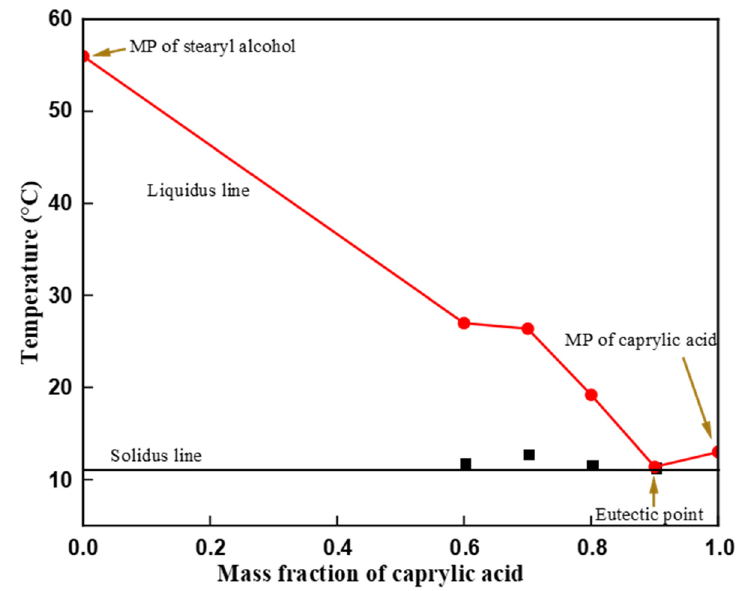
Figure 5. Phase diagram of the caprylic acid ‐ stearyl alcohol. The DSC heating and cooling curve for the eutectic caprylic acid ‐ stearyl alcohol mix ‐ ture is shown in Figure 6. The endotherm for the binary mixture shows the onset/peak melting point temperature of 11.4 °C/17.4 °C with the latent heat of fusion ( Δ H m ) of 154.4 J/g. The exotherm presents an onset/peak freezing point temperature of 11.8 °C/8.7 °C with Δ H f of 150.5 J/g. The specific heat of the eutectic material was measured with DSC at three different states. Specific heat in solid phase (1.690 J/g.K at 0 °C), during phase change (27.2 J/g.K at 16.9 °C), and in liquid phase (1.9 J/g.K at 26.9 °C). The caprylic ‐ palmitic acid eu ‐ tectic PCM reported in the literature has an 11.33 °C melting temperature with 116.47 J/g [23]. The eutectic PCM prepared in this work has a higher latent heat of fusion, which makes it a good fit for CTES applications. The degree of supercooling is an undesirable factor linked to the PCM and was higher for the pure materials utilized to prepare the binary mixture. The befitting thermal properties and lower degree of supercooling make the novel eutectic mixture suitable for cooling applications. The onset melting point tem ‐ perature of the caprylic acid ‐ stearyl alcohol binary mixture makes it a potential candidate for CTES, as few PCMs exist in this temperature range [32].